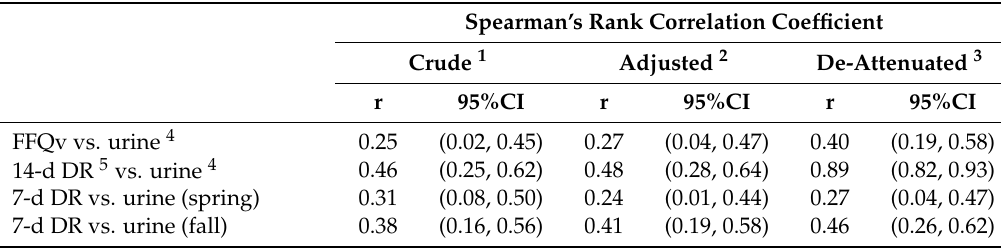
Table 3. The correlations between urinary sugars and dietary sugars by DR or FFQ ( n = 72, Cohort I). Spearman’s Rank Correlation